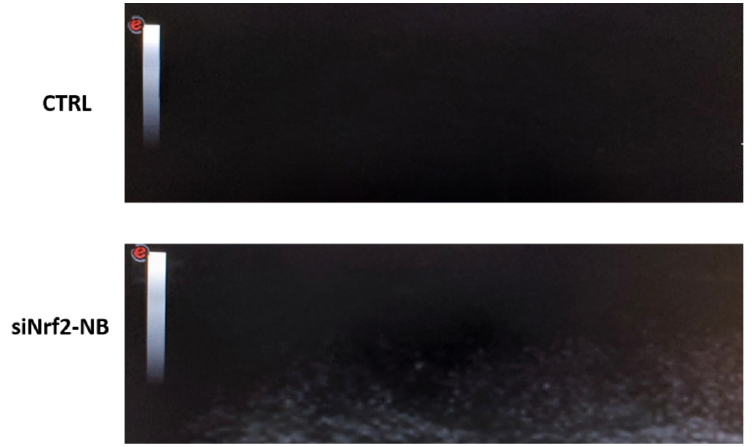
Figure 7. Representative snapshots of the B mode cineloops of the control experiment (ultrapure water without NBs) and siNrf2-NB (MI = 0.8, frequency = 12 MHz).